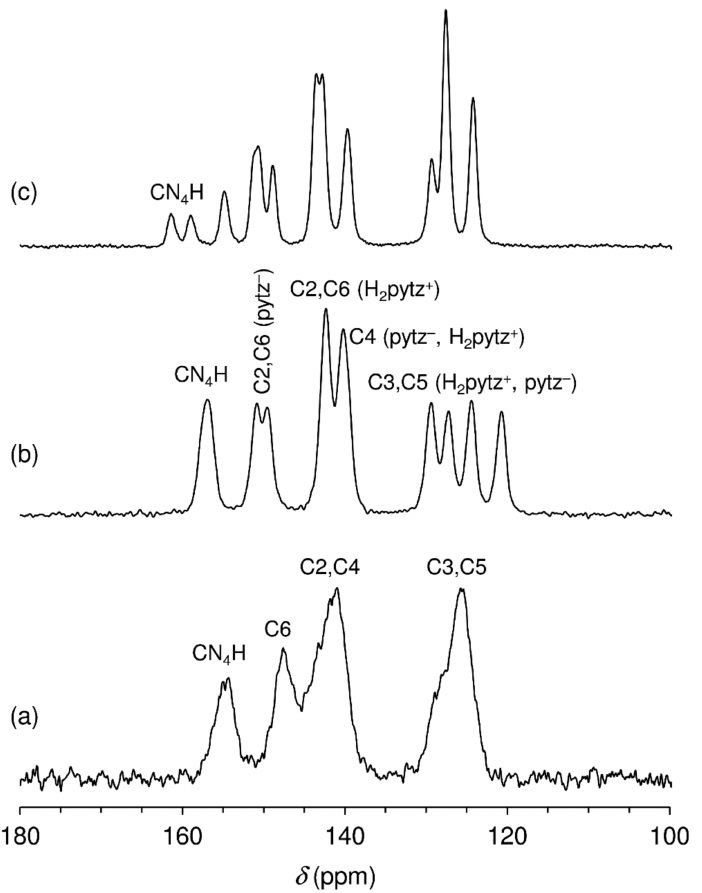
Figure 6. 13 C{ 1 H} cross polarization (CP) magic-angle spinning (MAS) NMR spectra of ( a ) Hpytz, ( b ) compound 1 , and ( c ) hybrid 2